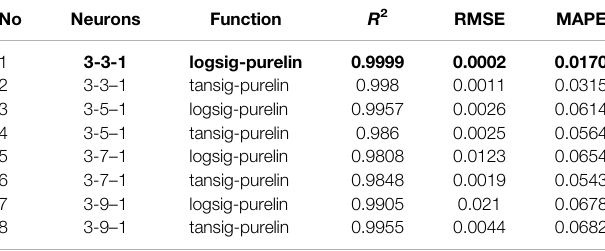
TABLE 3 | Amount of regressions for different ANN